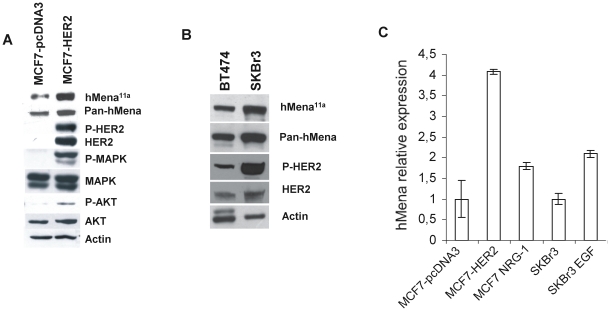
HER2 overexpression and activity affect hMena/hMena11a expression in human breast cancer cell lines.
A. HER2 transfection affects hMena expression in MCF7 breast cancer cells. Western blot analysis of MCF7-pcDNA3 and MCF7-HER2 lysates (50 µg) with the indicated antibodies. Two different antibodies for hMena have been used: the pan-hMena antibody, recognizing hMena and hMena11a as a doublet of 88–90 kDa, and the anti-hMena11a specific antibody. Membranes were sequentially stripped and reprobed with the indicated total and phospho-specific antibodies. B. hMena/hMena11a expression in HER2 overexpressing breast cancer cell lines. Western blot analysis of BT474 and SKBr3 breast cancer cell line lysates (50 µg) with the indicated antibodies. As loading control, blots were probed with anti-Actin mAb (1 µg/ml). C. HER2 transfection, NRG and EGF treatment affect hMena expression at mRNA level. QRT-PCR analysis of hMena and housekeeping β-Actin mRNA levels performed on 10 ng of total RNA from the untreated MCF7-pcDNA3, HER2 transfected MCF7, or NRG1 treated MCF7 breast cancer cell line and SKBr3 cells either untreated or treated with EGF. Results are given as the ratio between hMena and β-Actin genes relative to the internal control.